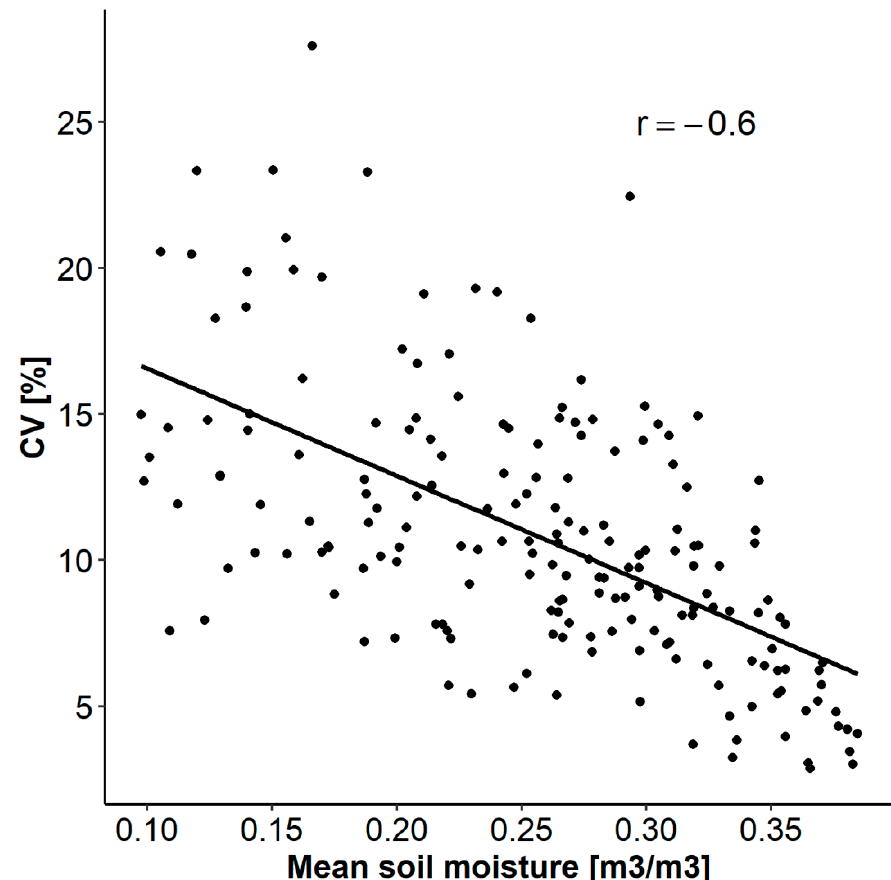
Figure 4. The relation between the coefficients of variation (CV, %) and long-term mean ASM in the UBNB.